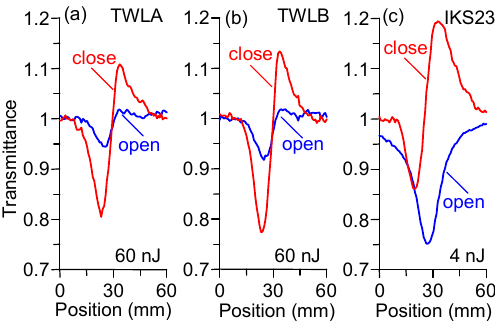
Figure 2. Open (blue) and closed (red) aperture z-scan traces for ( a ) TWLA, ( b ) TWLB, ( c ) IKS23. Incident optical energy is depicted in the corresponding figures.